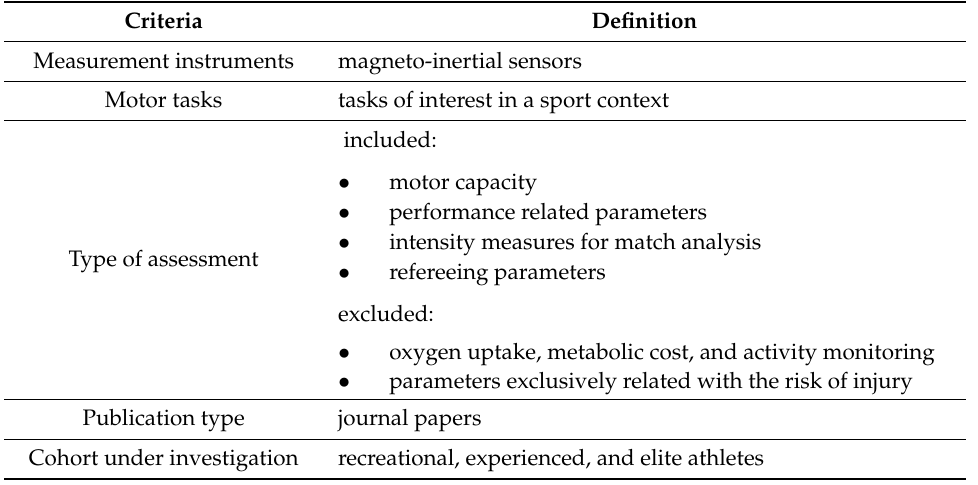
Table 1. Inclusion and exclusion criteria considered for the current systematic